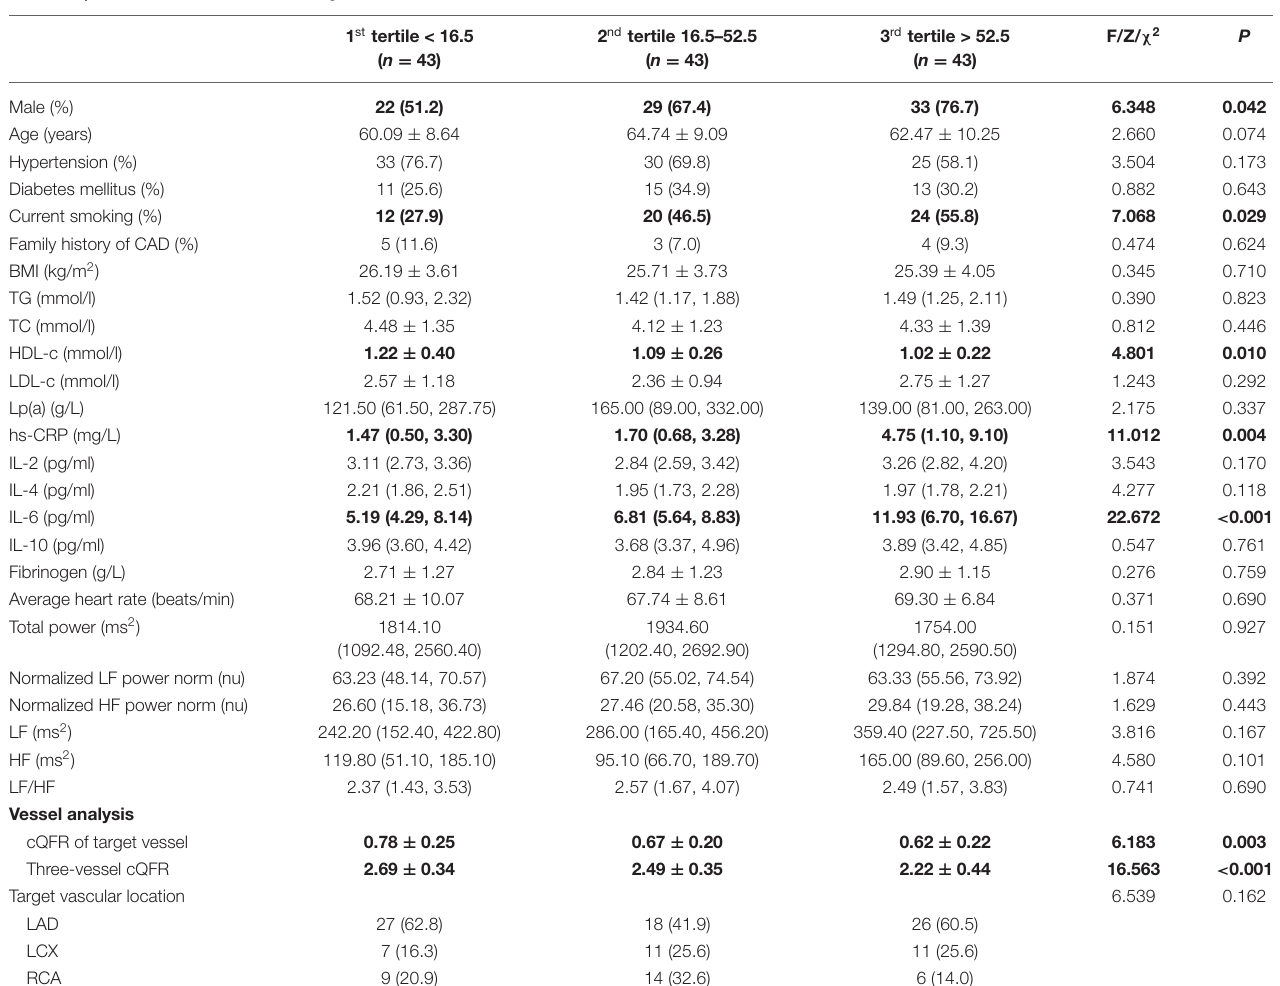
TABLE 3 | Patient characteristics according to Gensini